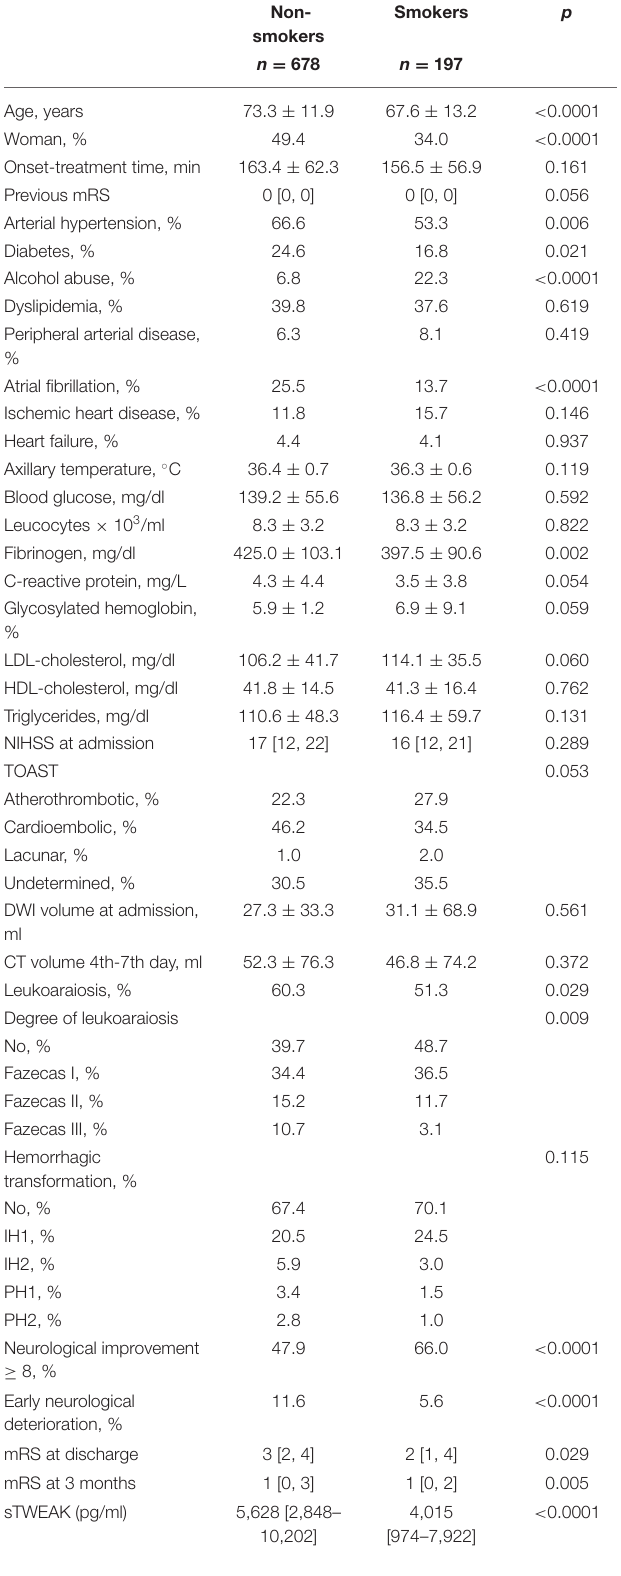
TABLE 1 | Clinical variables, biochemical parameters, and neuroimaging values of patients classified according to their smoking